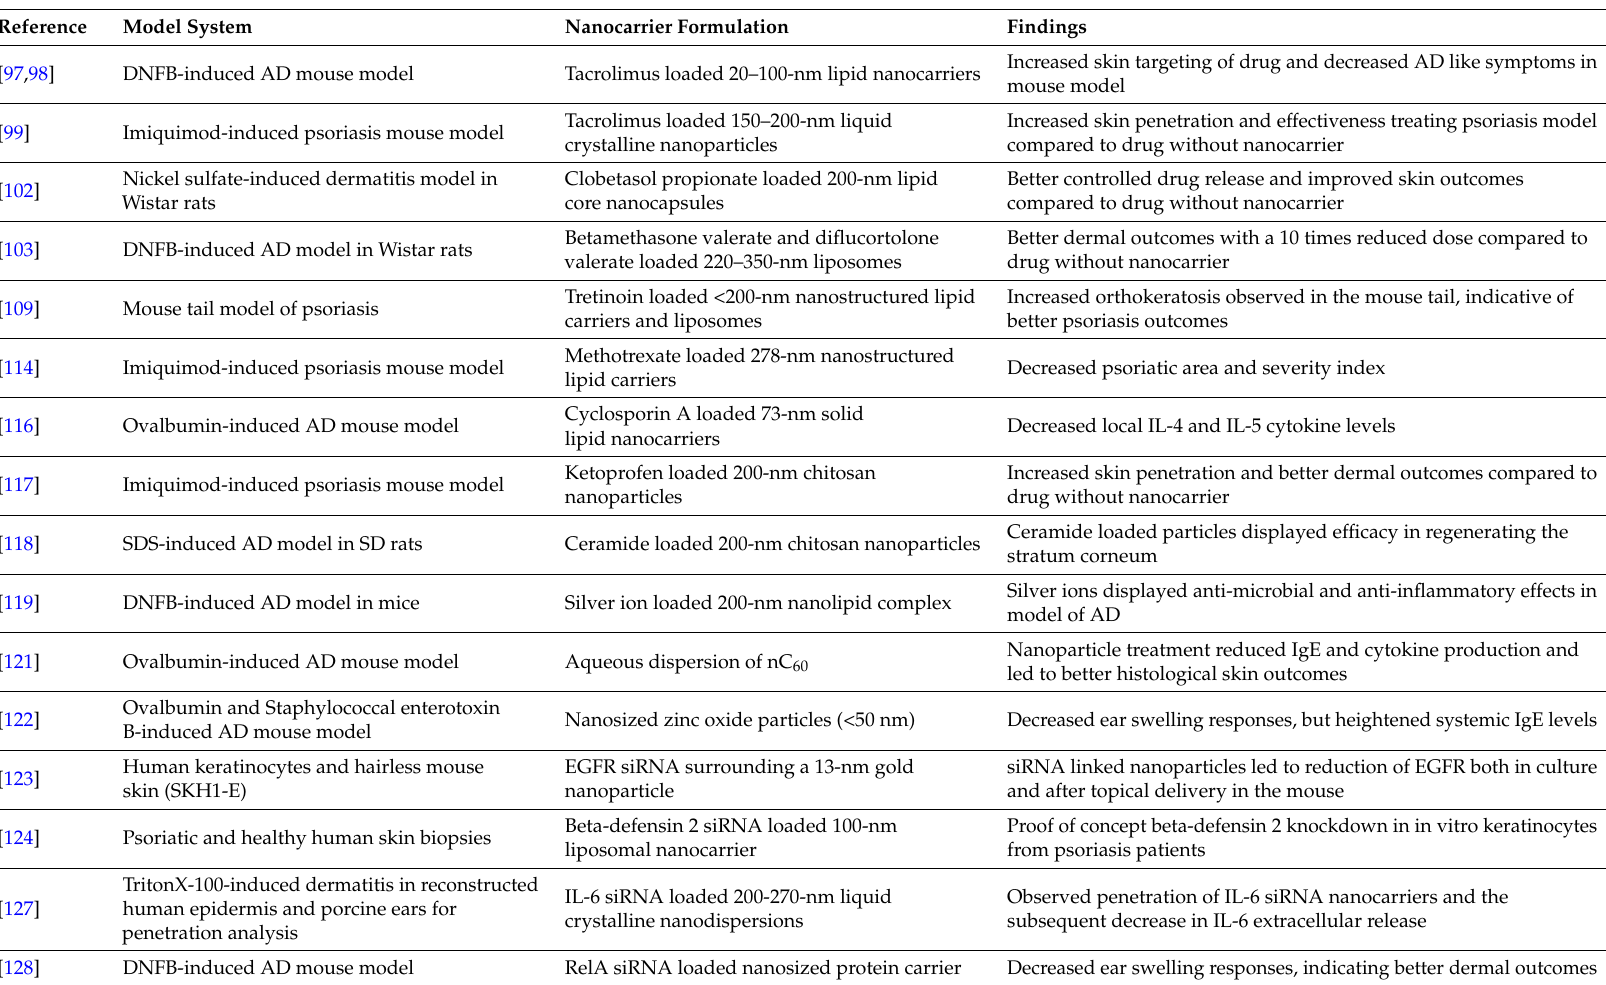
Table 1. Summary of all in vitro and in vivo efficacy studies for AD or psoriasis nanocarrier systems. DNFB: dinitrofluorobenzene; SDS: sodium dodecyl